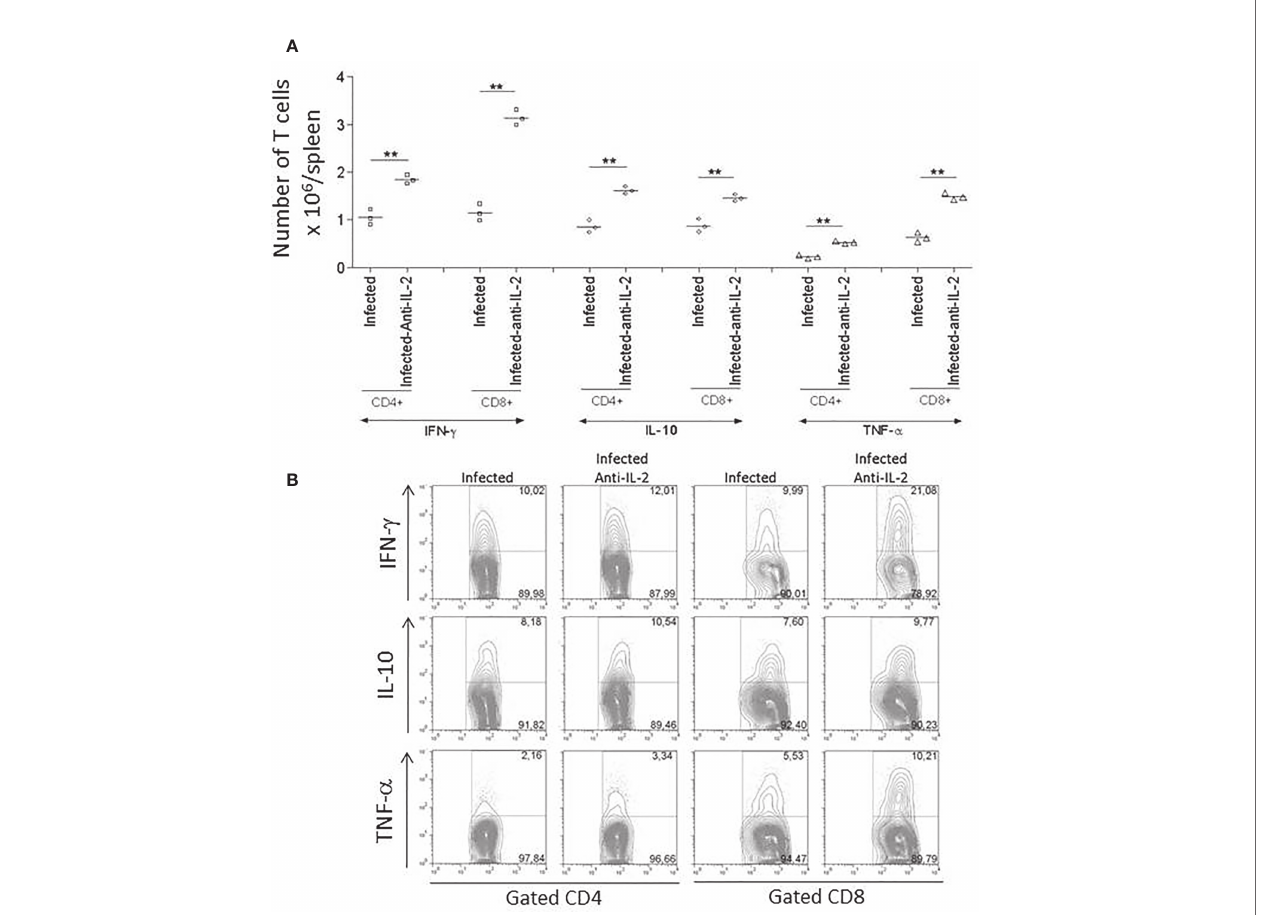
FIGURE 5 | Total numbers of splenic T cells producing IFN- g , IL-10, and TNF- a were increased in infected mice treated with anti-IL-2 mAb. Panel (A) shows the numbers of splenic CD4 + and CD8 + T cells producing IFN- g , IL-10, and TNF- a compared to infected control groups that received rat Ig. The results of three individual mice per group are shown. The FACS plot panel (B) represents one experiment demonstrating gated CD4 + and CD8 + splenic T cells from 3 to 4 pooled spleens from infected rat Ig- or anti-IL-2-treated mice stained for intracellular cytokines as indicated. Spleen cells were stimulated with anti-CD3 for 24 hours and brefeldin-A for the last six hours. The experiment represents a total of three studies with similar results (**P < 0.01, n = 3 group, Mann-Whitney